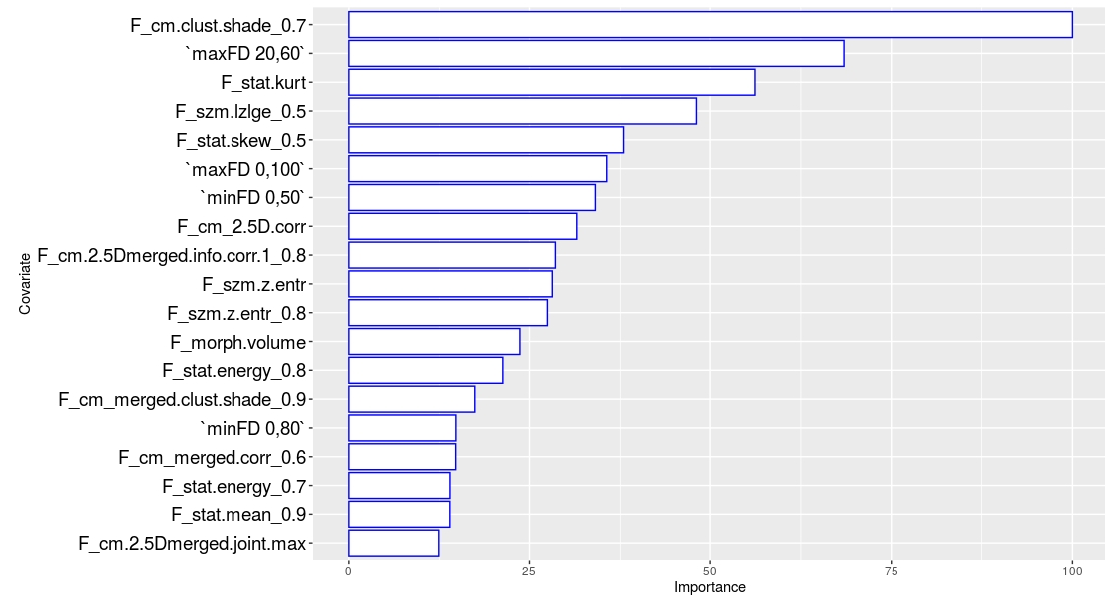
Figure 3. Importance of the parameters included in the model.